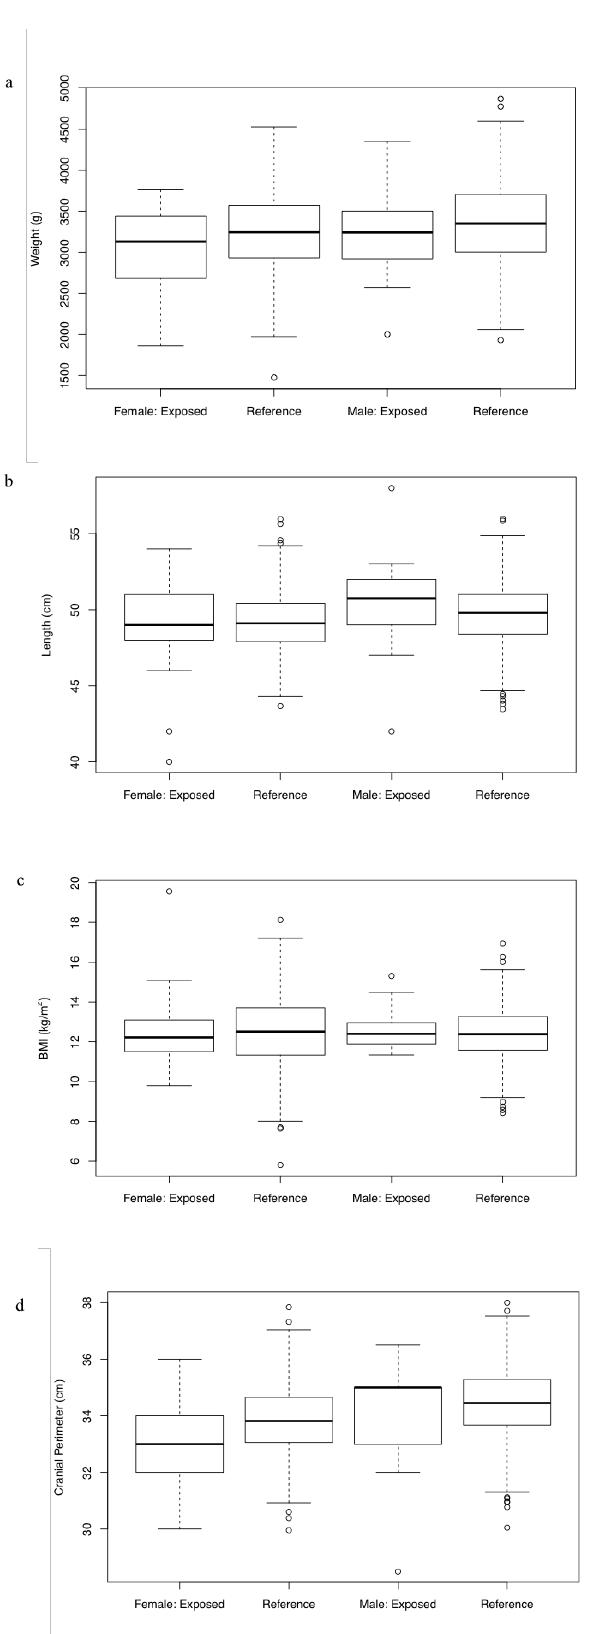
Figure 2. ( a–d ) Comparisons of anthropometric scores (weight, length, BMI, and cranial perimeter) between the exposed children and the reference WHO